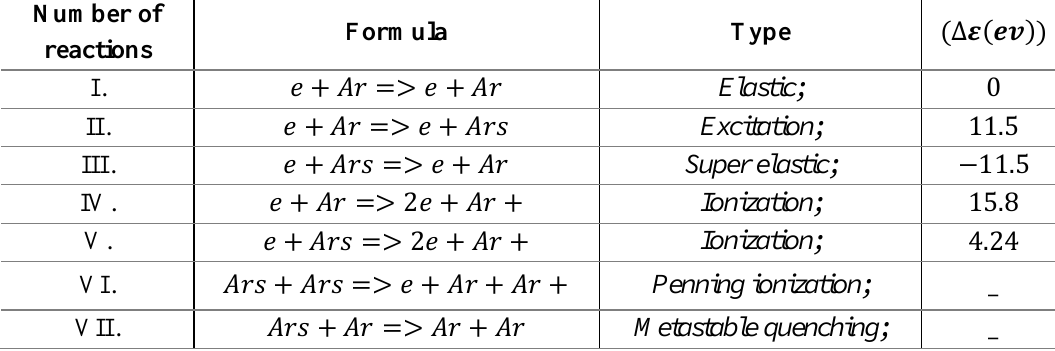
Table 1: 𝑨𝒓 gas reaction and collisions